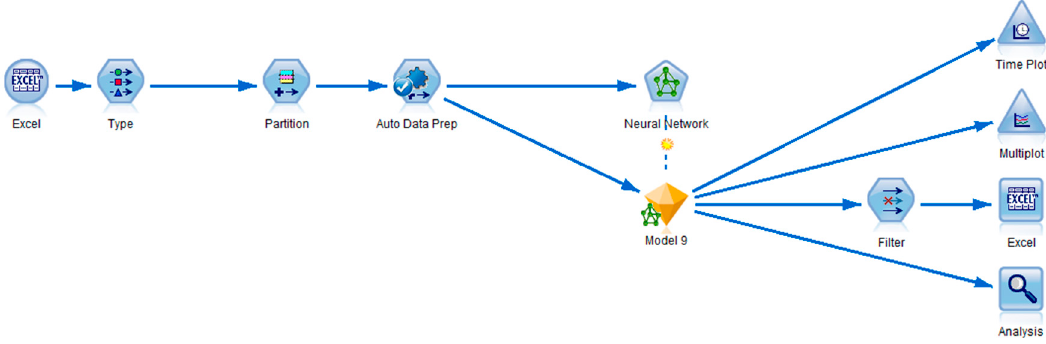
Figure 9. The developed stream using IBM SPSS Modeler.